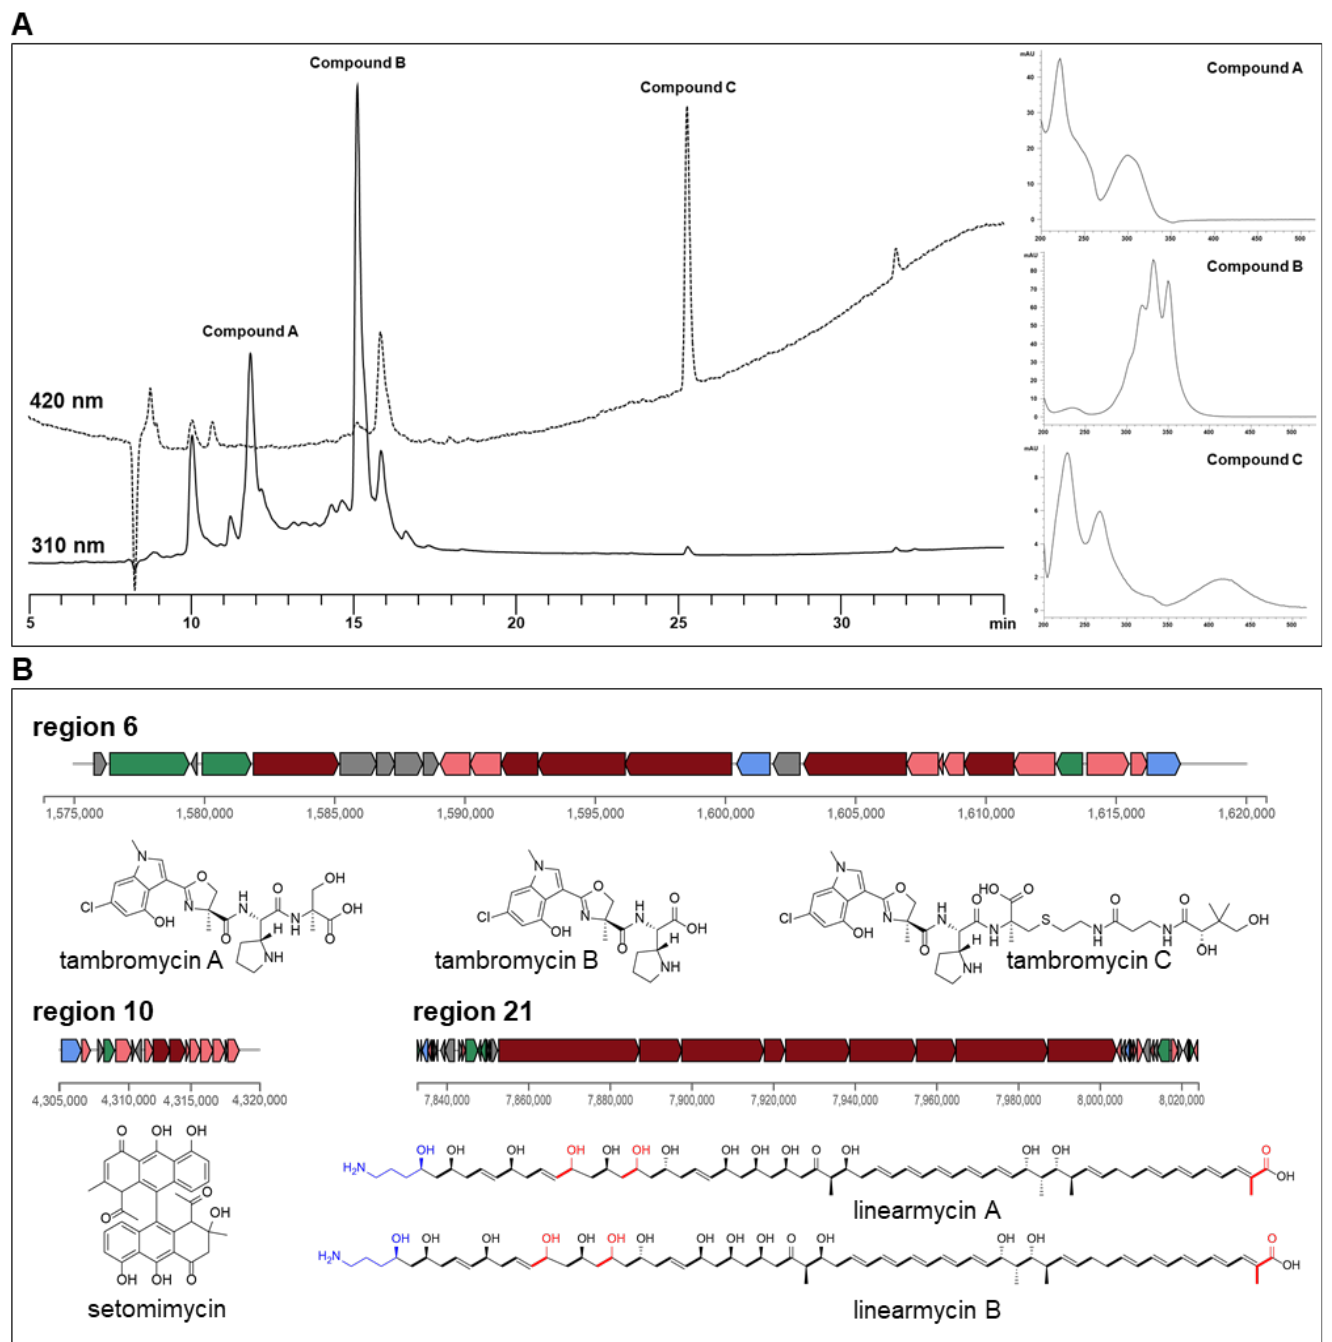
Figure 2. HPLC chromatogram at 310 and 420 nm of JCM 3382 culture extract and metabolites with representative UV absorption spectra ( A ). Biosynthetic gene clusters (regions 6, 10, and 21) activated in this study are shown with their products ( B ).